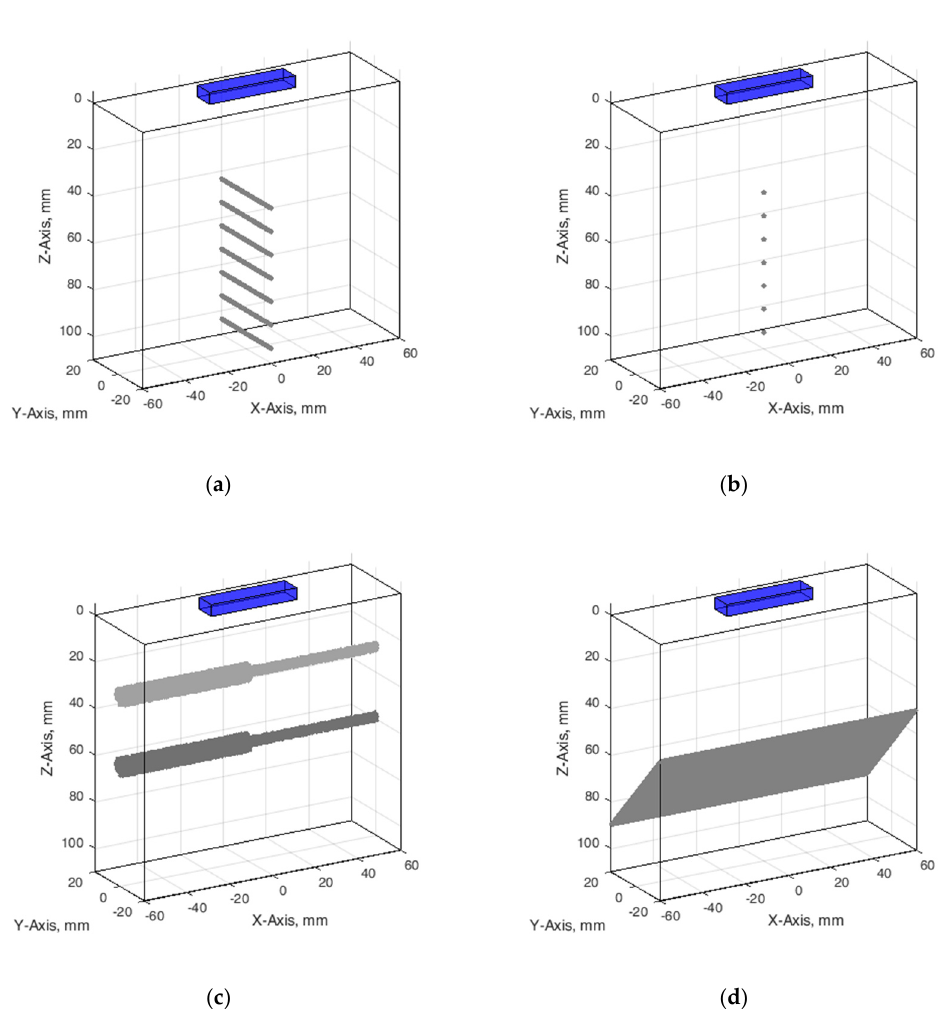
Figure 3. Configuration of digital phantoms: ( a ) wire phantom, ( b ) point phantom, ( c ) contrast phantom, ( d ) slice thickness phantom. The cuboids on the top of digital phantoms have marked a position of the digital ultrasound transducer.